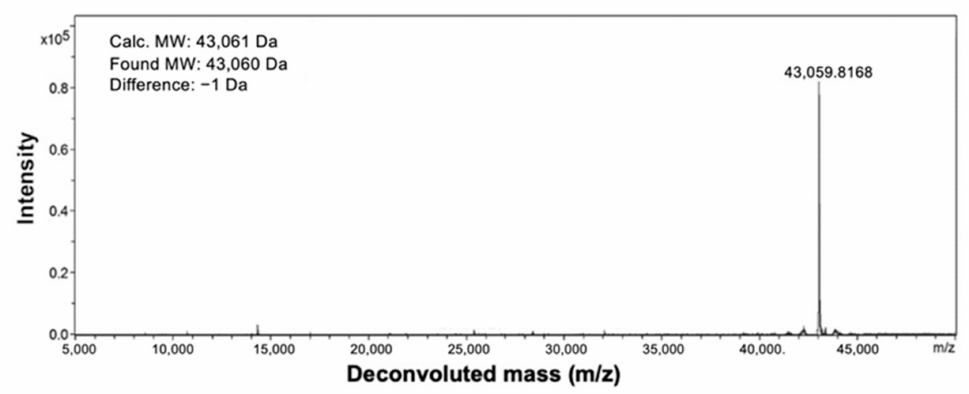
Figure 1. ESI-MS analysis of Ec1-LoPE fusion protein. The observed molecular weight is 43,060 Da (calculated value 43,061